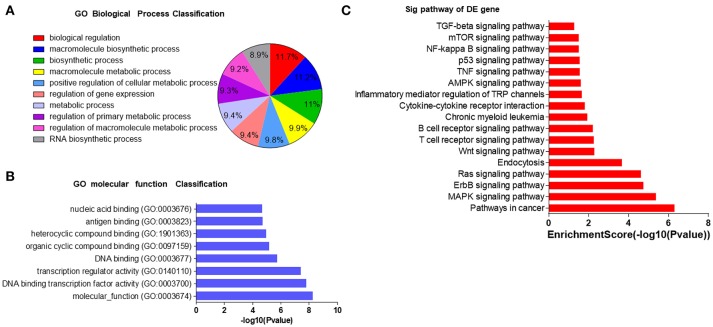
GO and KEGG analyses of potential roles of selected serum miRNAs. (A,B) The most enriched GO biological processes and molecular functions of 6 selected miRNAs. GO, molecular function for all miRNA targets. (C) Pathway enrichment analysis based on the miRNA target genes. The vertical axis represents the pathway category and the horizontal axis represents the enrichment score of the pathways and KEGG pathway terms (P < 0.05 and FDR < 0.05).